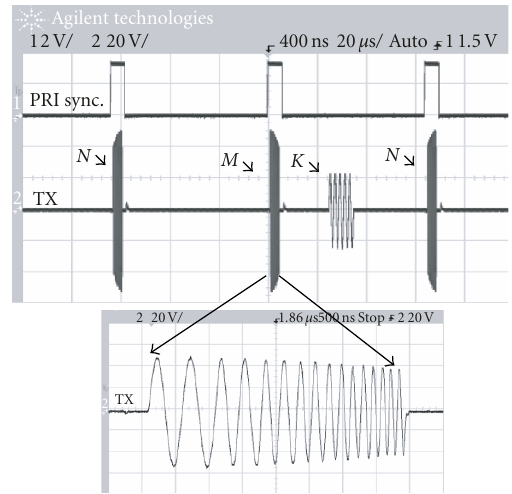
Figure 3: Oscilloscope acquisition of an excitation sequence involving 3 di ff erent waveforms over two consecutive PRIs. The bottom box shows the upward chirp signal on expanded scale. (PRI length ≈ 65